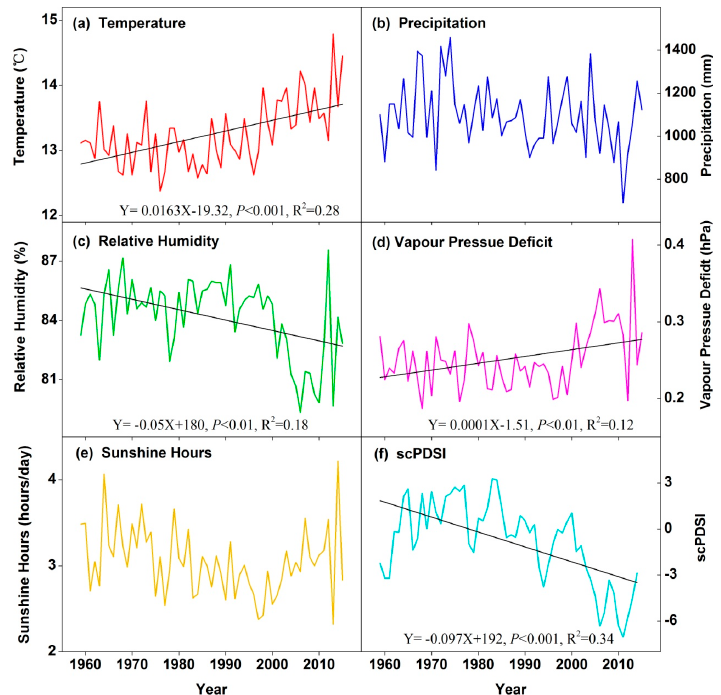
Figure 3. Climatic characteristic in the Xi Shui meteorological station from 1960 to 2015. ( a ) Annual mean temperature; ( b ) annual total precipitation; ( c ) relative humidity; ( d ) vapor pressure deficit; ( e ) annual sunshine hours; ( f ) Annual scPDSI. Linear regression lines and regression parameters are shown for the significant relationships ( p < 0.05).